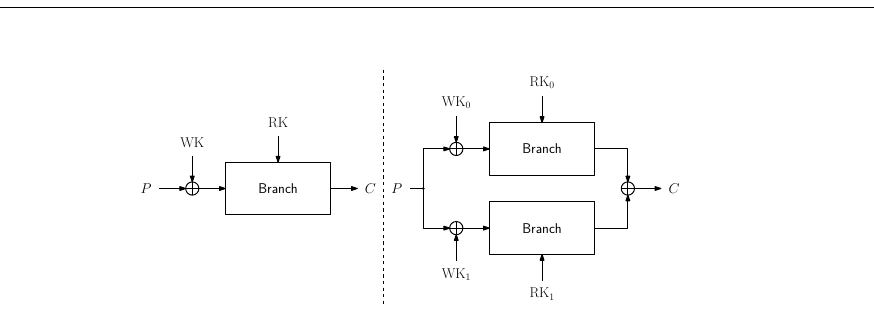
Figure 8: (Left) The toy cipher using a single branch and (Right) that using double branches, where WK and RK are the whitening key and round key,